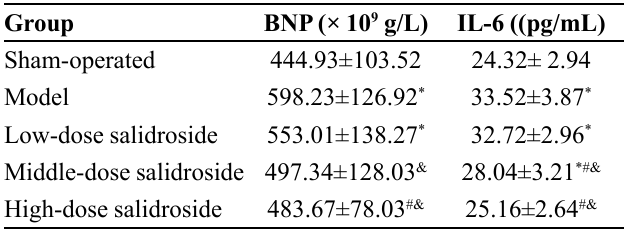
TABLE II - Effects of salidroside on serum BNP and IL-6 levels in